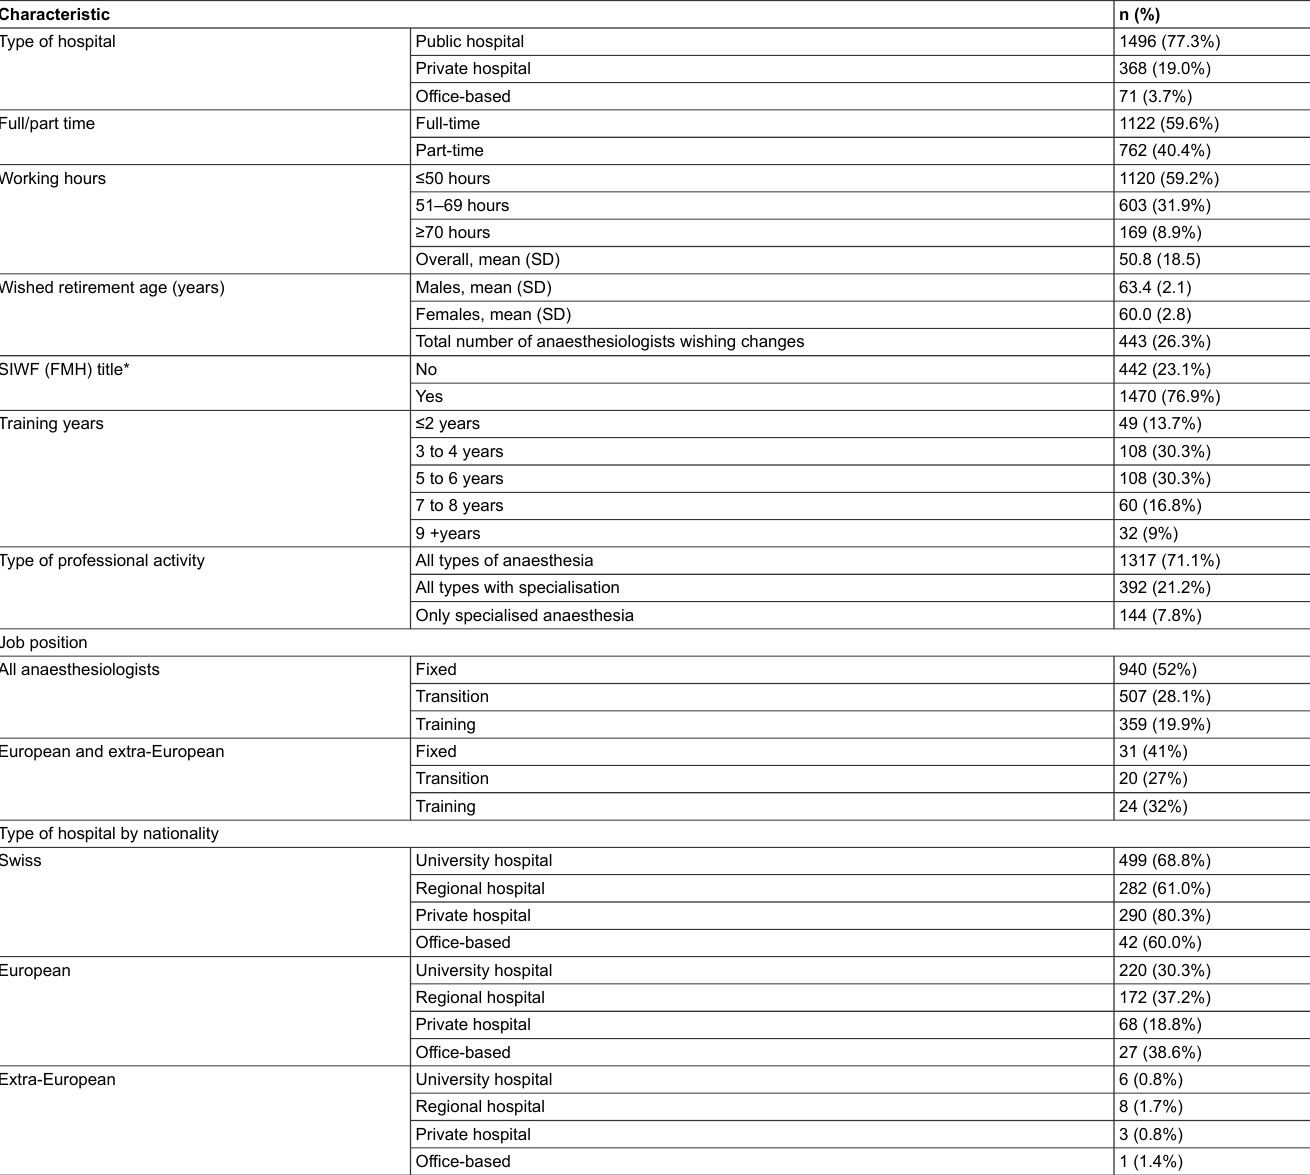
Table 3: Professional characteristics and life plans of anaesthesiologists in Switzerland. Characteristic